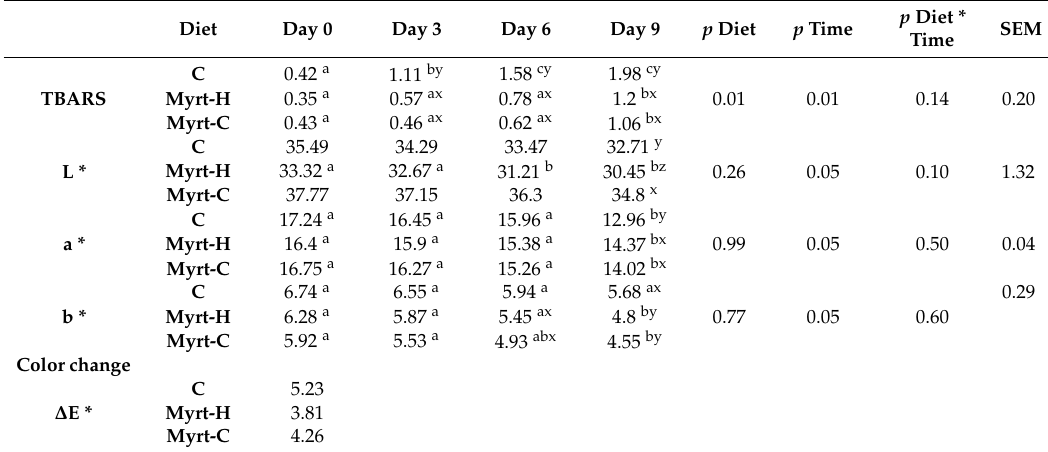
Table 2. Color parameters and lipid oxidation evolution of meat from ewes fed myrtle